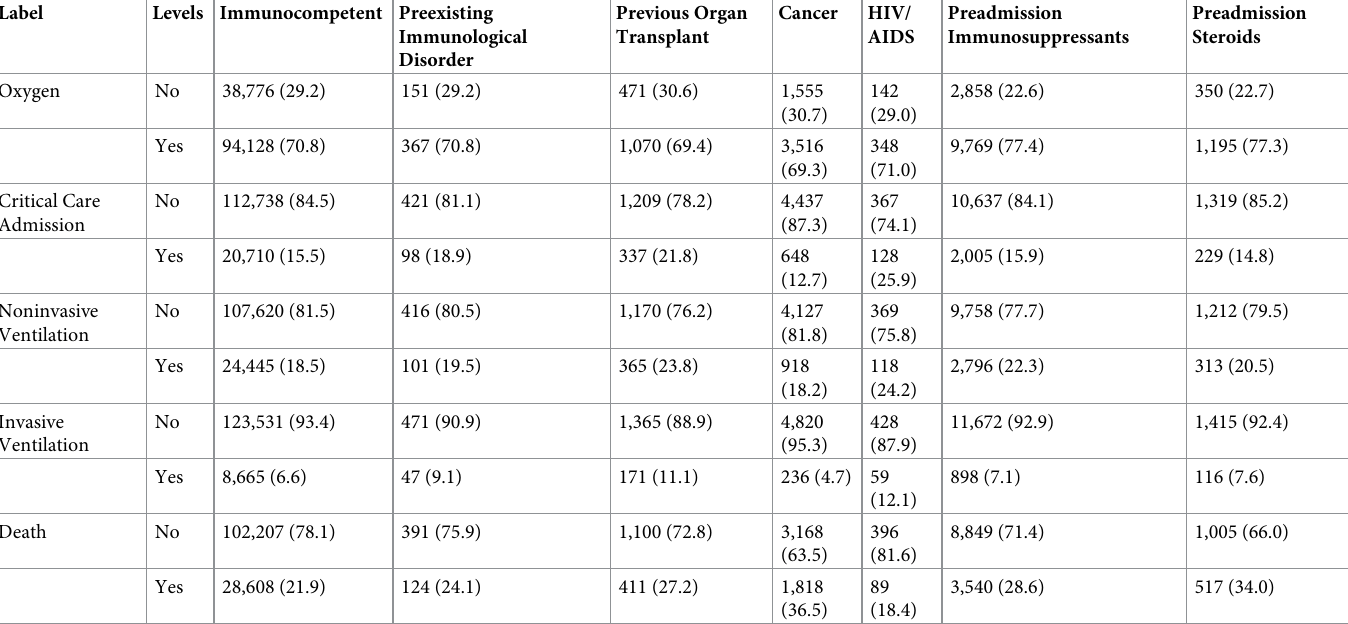
Table 2. Outcomes by reason for immunocompromise. Data are numbers of patients (%). Label Levels Immunocompetent Preexisting